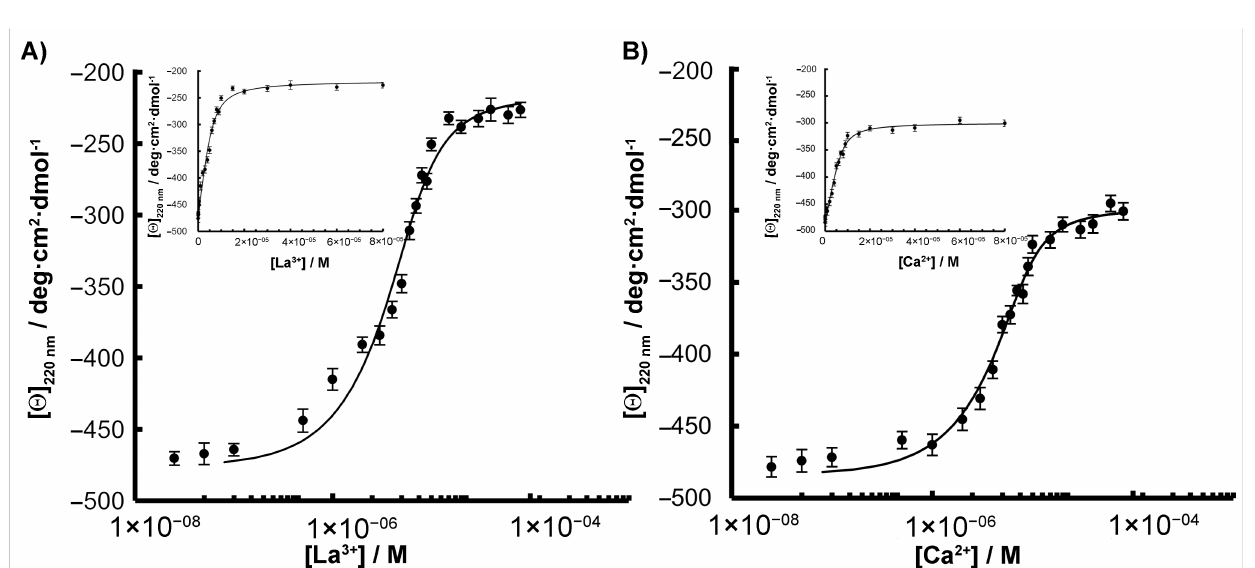
Figure 3. Metal titrations of 8 µ M SPL2cyt with ( A ) La 3+ and ( B ) Ca 2+ monitored by CD spectroscopy. Data were fitted to the Hill equation to determine Kd and are reported in Table 1. Binding titrations plotted with a linear scale are also shown